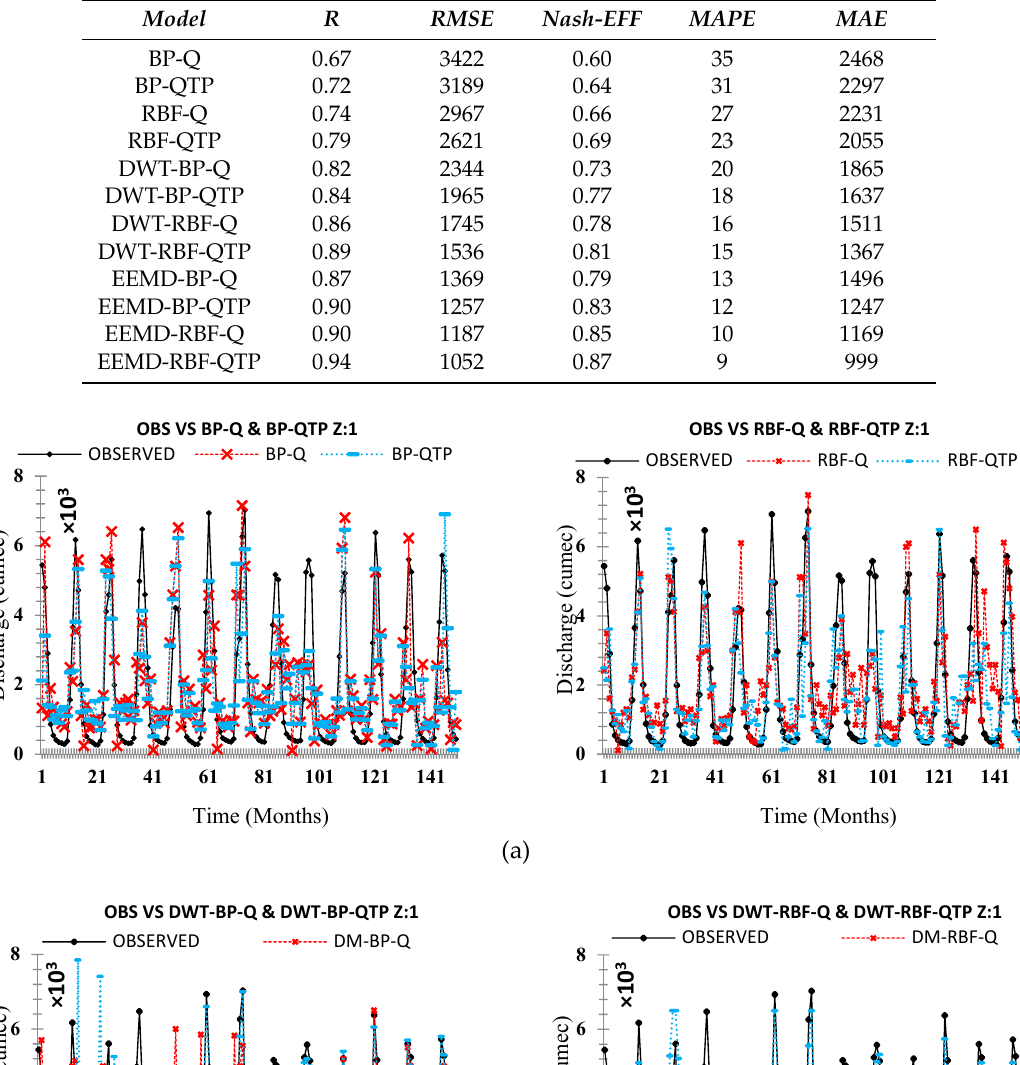
Table 11. Performance evaluation of the applied models for zone three during the validation